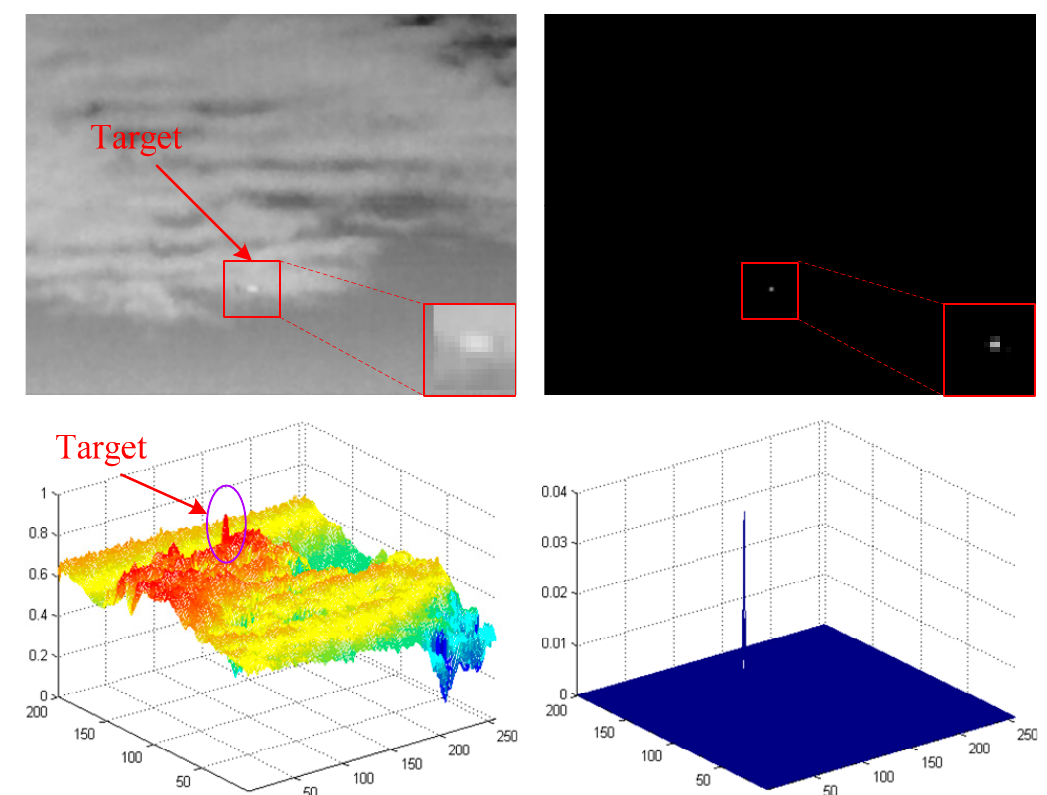
Figure 5. Infrared small target detection result of NOLC model.